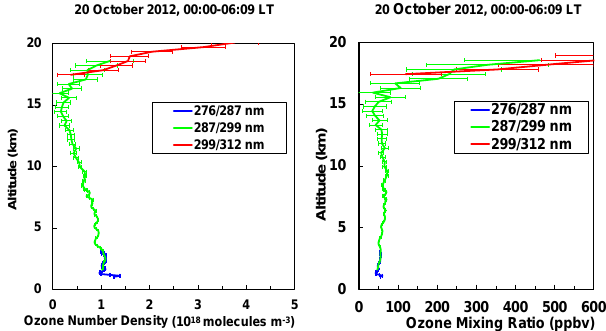
Figure 2. Vertical profiles of ozone number density (left panel) and ozone volume mixing ratio (right panel) over Saga observed by DIAL on 20 October 2012. The error bars show the statistical er- rors calculated from the lidar signal to noise ratios.